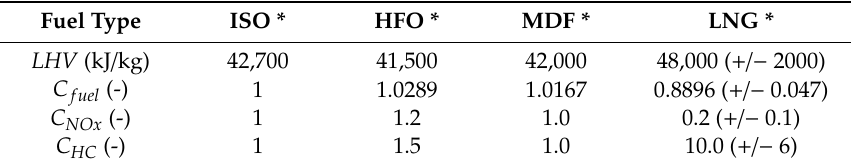
Table 3. Correcting factors of fuel consumption and NOx and HC